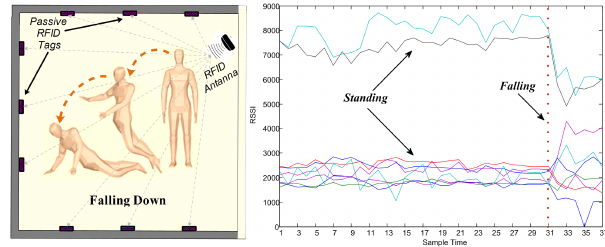
Figure 1: RSSIs variation patterns when falls